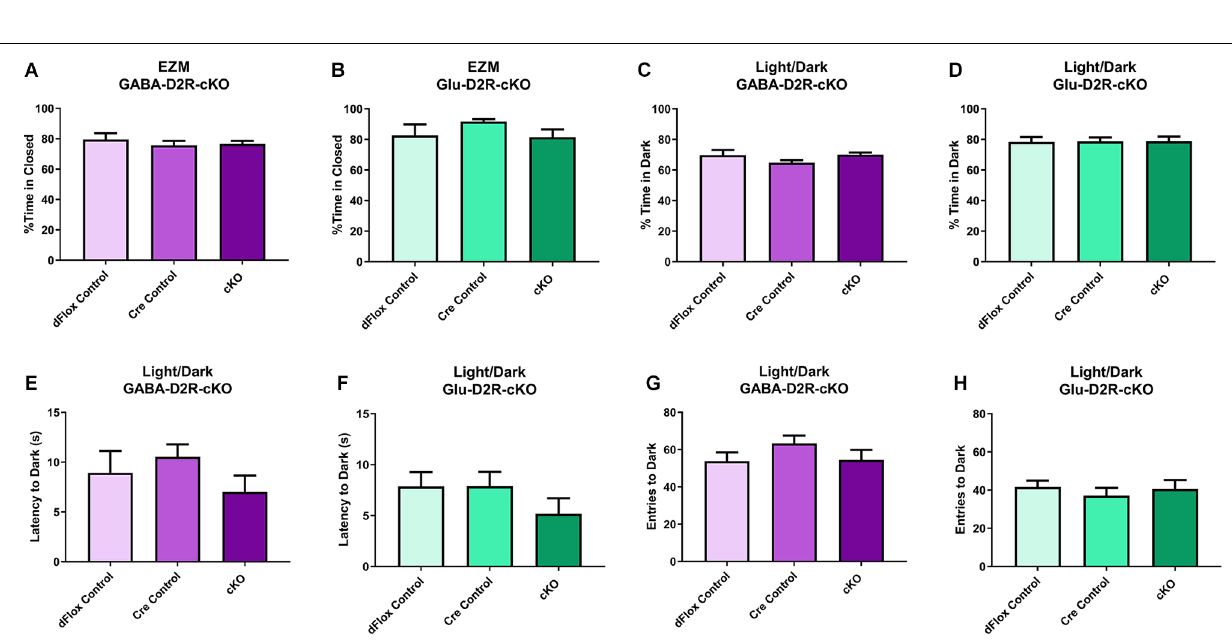
or Sex ( F (1,17.3) = 0.59, p = 0.4537). In terms of search strategy, all mice, regardless of genotype or mouse line, utilized the more disorganized random search strategy similarly in the initial training, before moving on to the more complex serial and